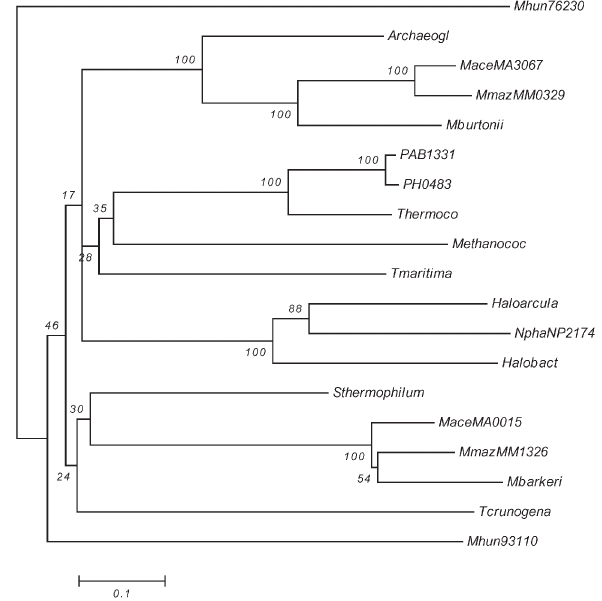
Figure 4. Phylogenetic analysis by neighbor-joining of putative two- component open reading frames (ORFs) from response regulator IV group arr18 and arr19 . Group arr18 = MaceMA0015, MbarA_0985 and MmazMM1326; and group arr19 = PAB1331, PH0483, Tkod_ 610170410, HaloVNG0973G, HmarrnAC2204, MaceMA3067, MmazMM0329, Mbur_401647530, AfulAF1041, MmarMMP0926, NphaNP2174A and Mhun_401793110. The bacterial ORFs are Sthermophilum, Tmaritima and Tcrunogena. Abbreviations: Thermoco = T. kodakaraensis ; Sthermophilum = S. thermophi- lum _3768360; Tmaritima = T.maritima MSB8_21060; and Tcruno- gena = T. crunogena Tcr0758